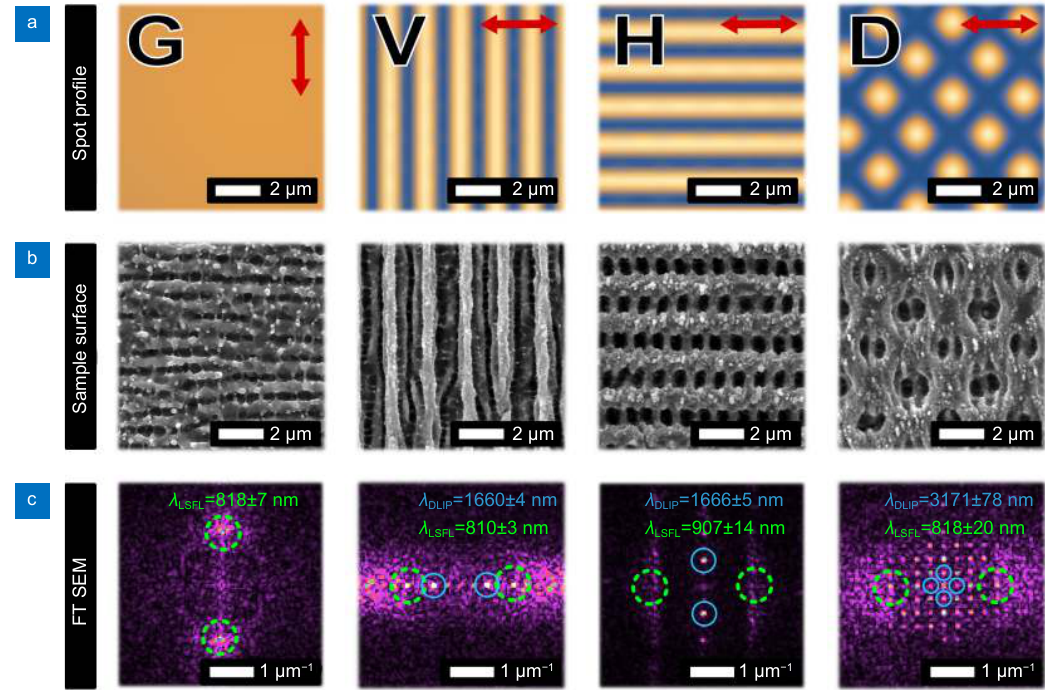
Fig. 3 | ( a ) Spot intensity distribution. ( b ) SEM images of processed surface. ( c ) Fourier transform diagrams, produced by trains of single pulses. The total number of pulses is NP = 50, the energy per pulse is E tot = 80 μJ for G , and E tot = 57 μJ for the DLIP distribution V , H and D . The red ar- row in A indicates the polarisation